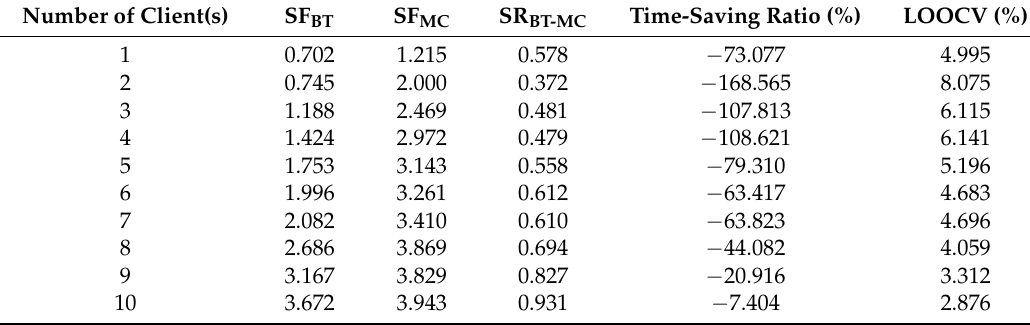
Table 4. Speedups, speedup ratios, time-saving, and leave-one-out cross-validation for BT to multicast solution. LOOCV: leave-one-out